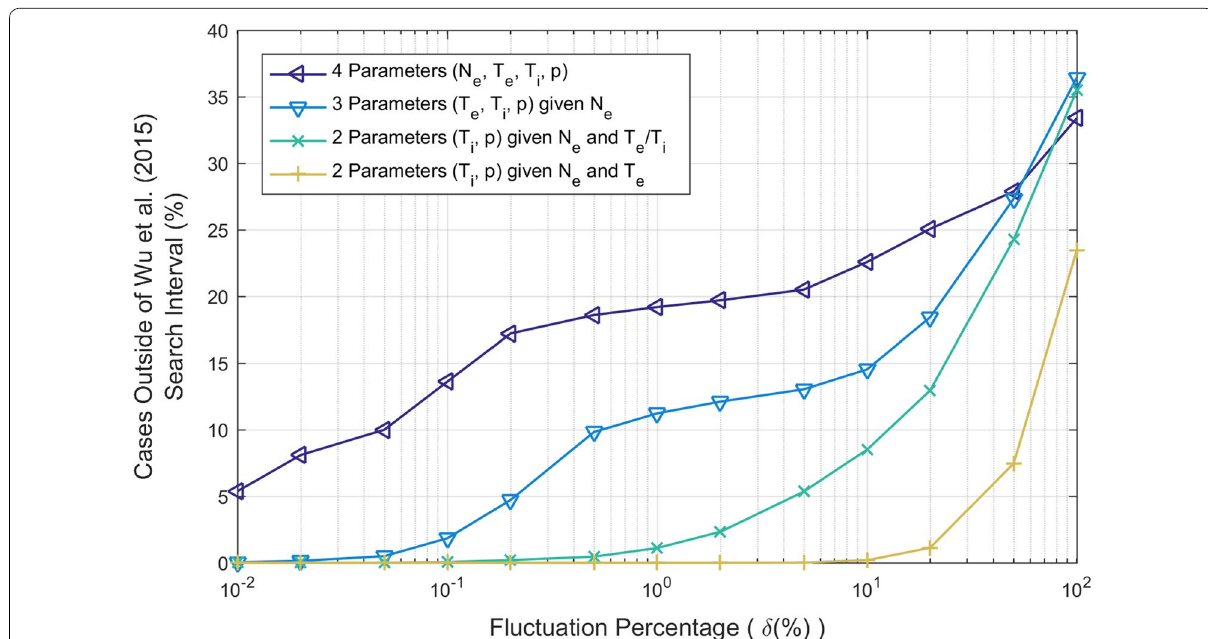
Fig. 4 Number of convergent solutions located outside of the search range defined by Wu et al. (2015), obtained from the analysis of the PSO simulations shown in Fig. 2 at different signal fluctuation percentages ( δ( % )